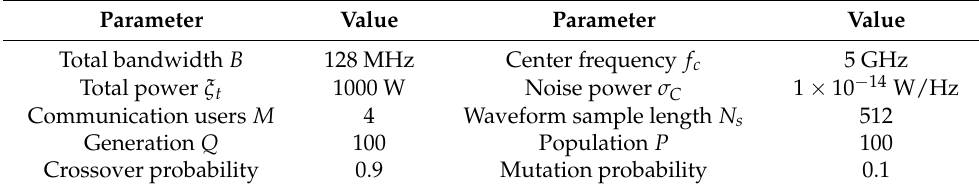
Table 1. Simulation